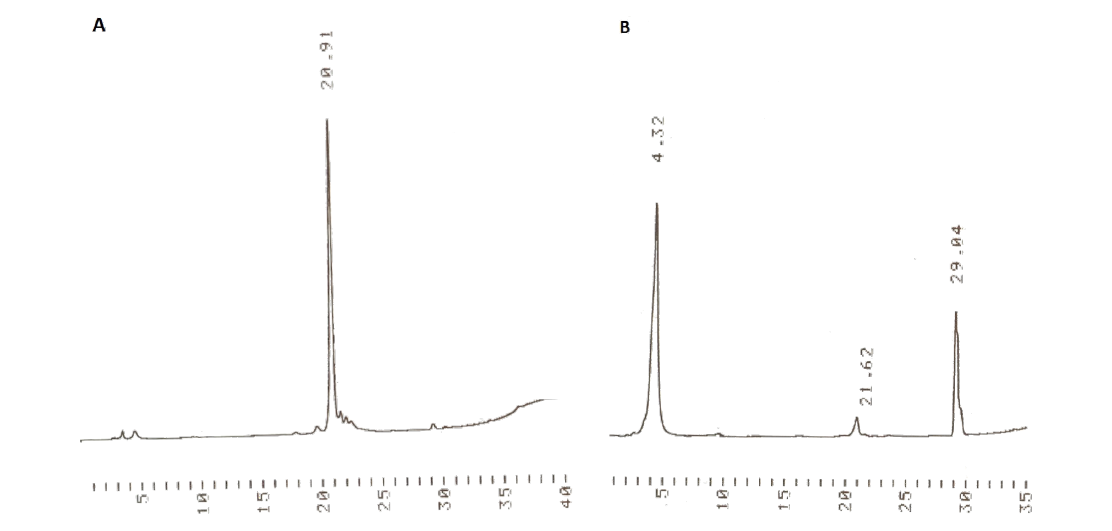
tection step. The MS data are given in Table 1. Figure 2 and